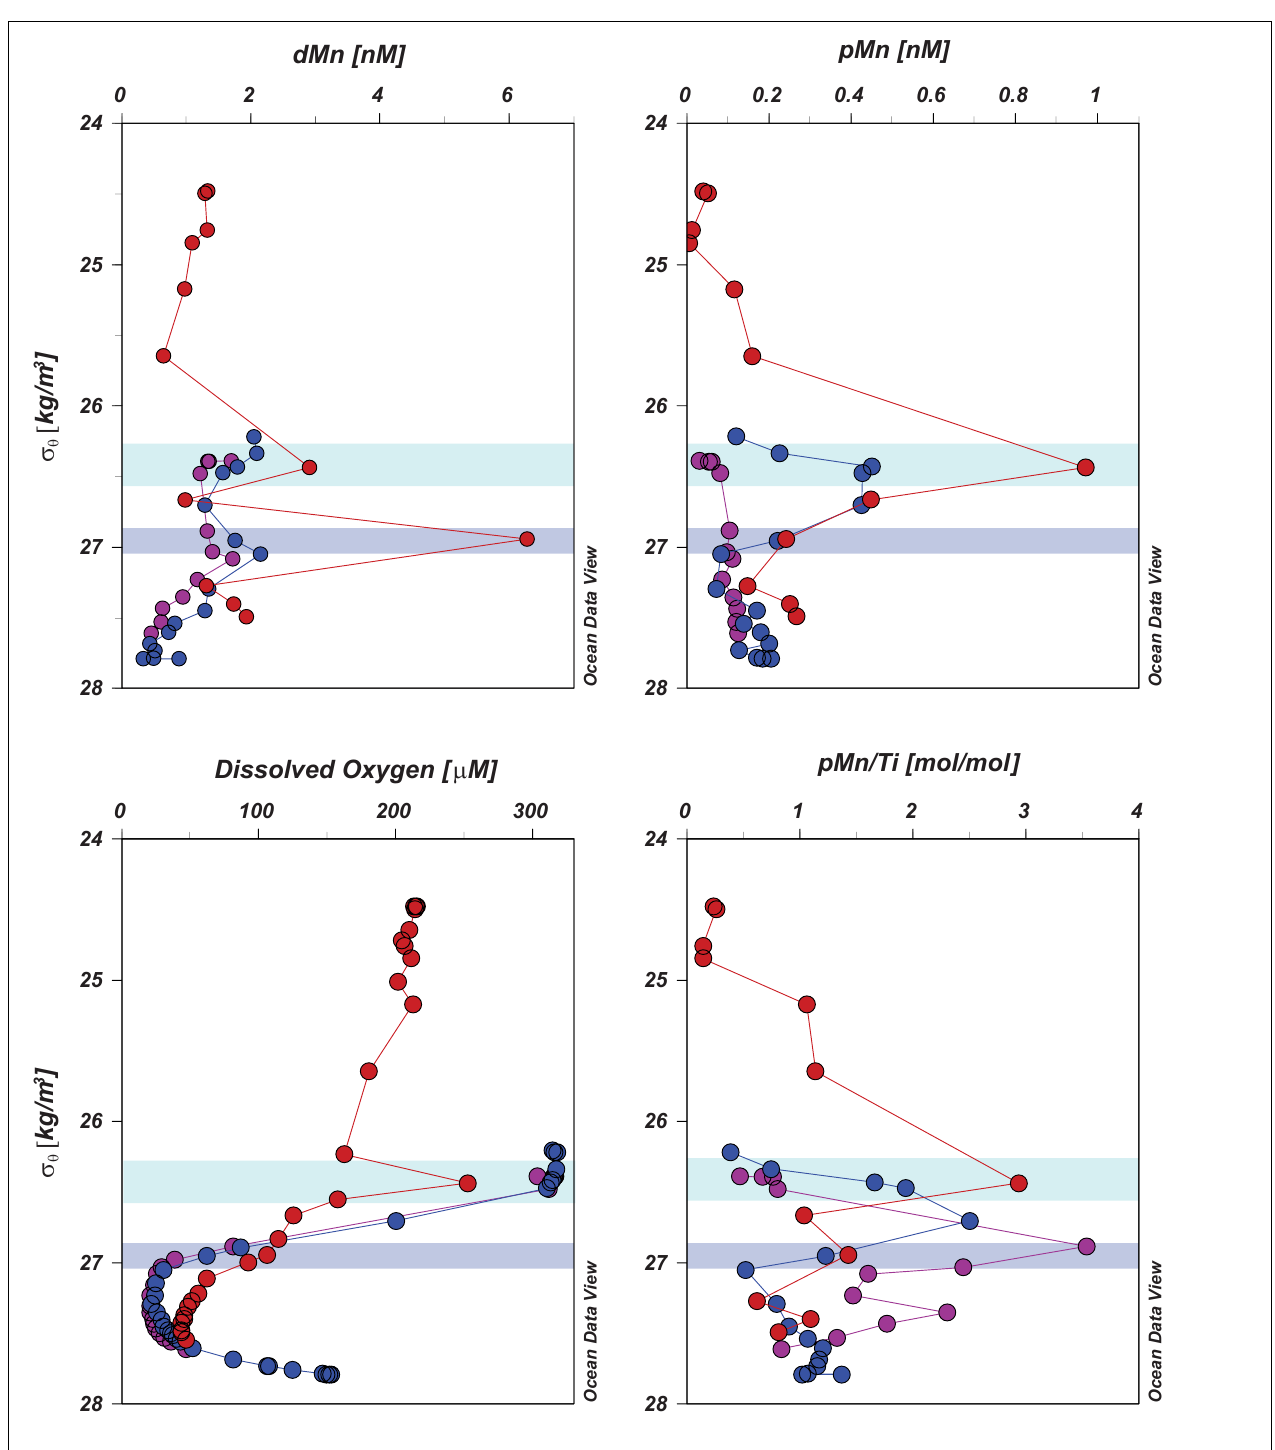
FIGURE 12 | Margin inputs of Mn in the WSG: Transport of Mn from the WSG, with increasing dissolved and particulate concentrations with increased contact time with the Kuril-Kamchatka margin. Note that the greatest increases occur along the 26.4–27.3 σ θ isopycnal surfaces, consistent with inputs from the Kuril-Kamchatka Margin and intermediate waters from the Sea of Okhotsk. Shaded areas show density ranges for the upper (green, 26.3–26.6 σ θ ) and lower (purple, 26.9–27.1 σ θ ) low temperature-low salinity intrusions.